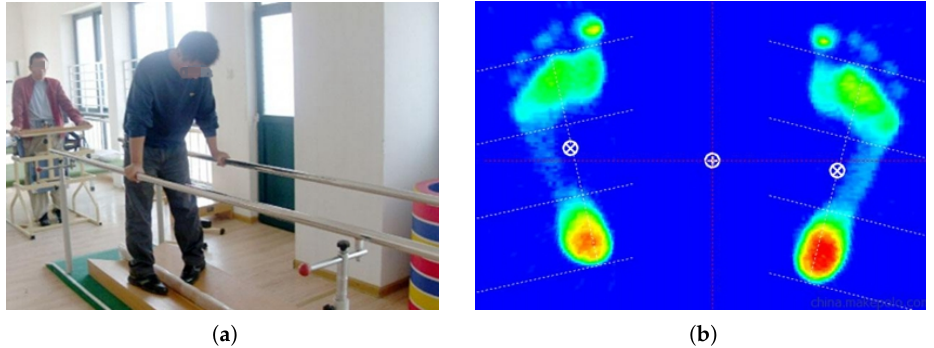
Figure 2. Traditional gait analysis methods: ( a ) Physician observation; ( b ) plantar pressure